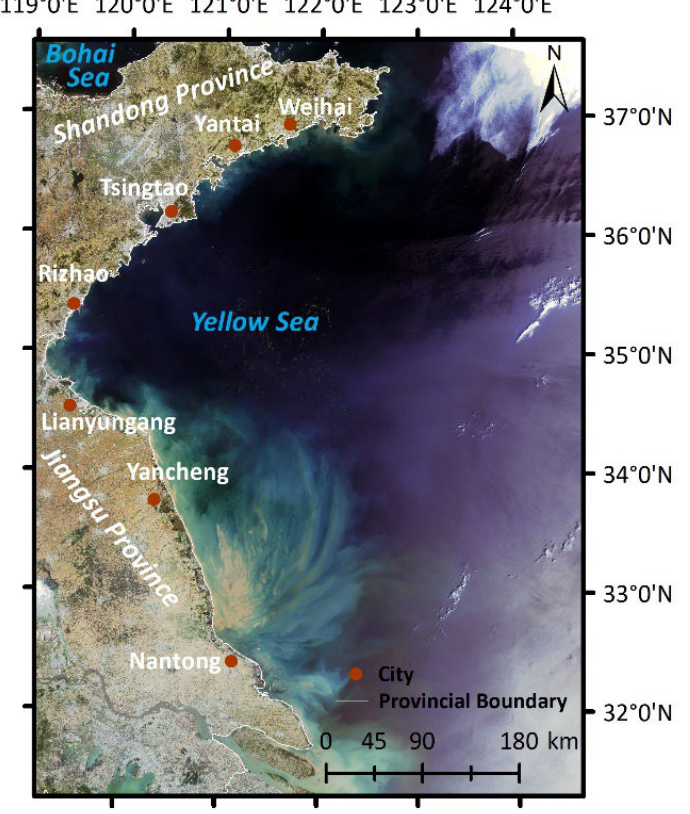
Figure 2. Map of the study area and major coastal cities. The background image is an HY-1C true color image from 6 June 2021.